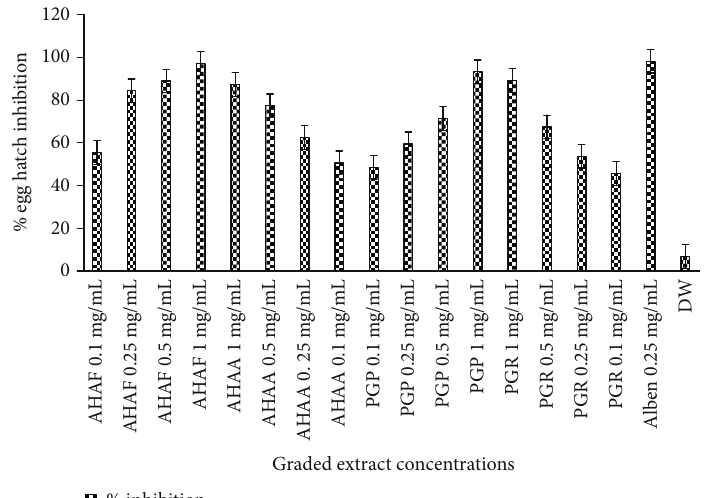
Figure 2: Relative egg hatching inhibition e ffi cacy of graded concentration of crude extracts of A . herba-alba and P . granatum . AHAF: A . herba-alba fl ower part, AHAA: A . herba-alba aerial part, PGP: P . granatum peel part, PGR: P . granatum root part, Alben: albendazole, DW: distilled